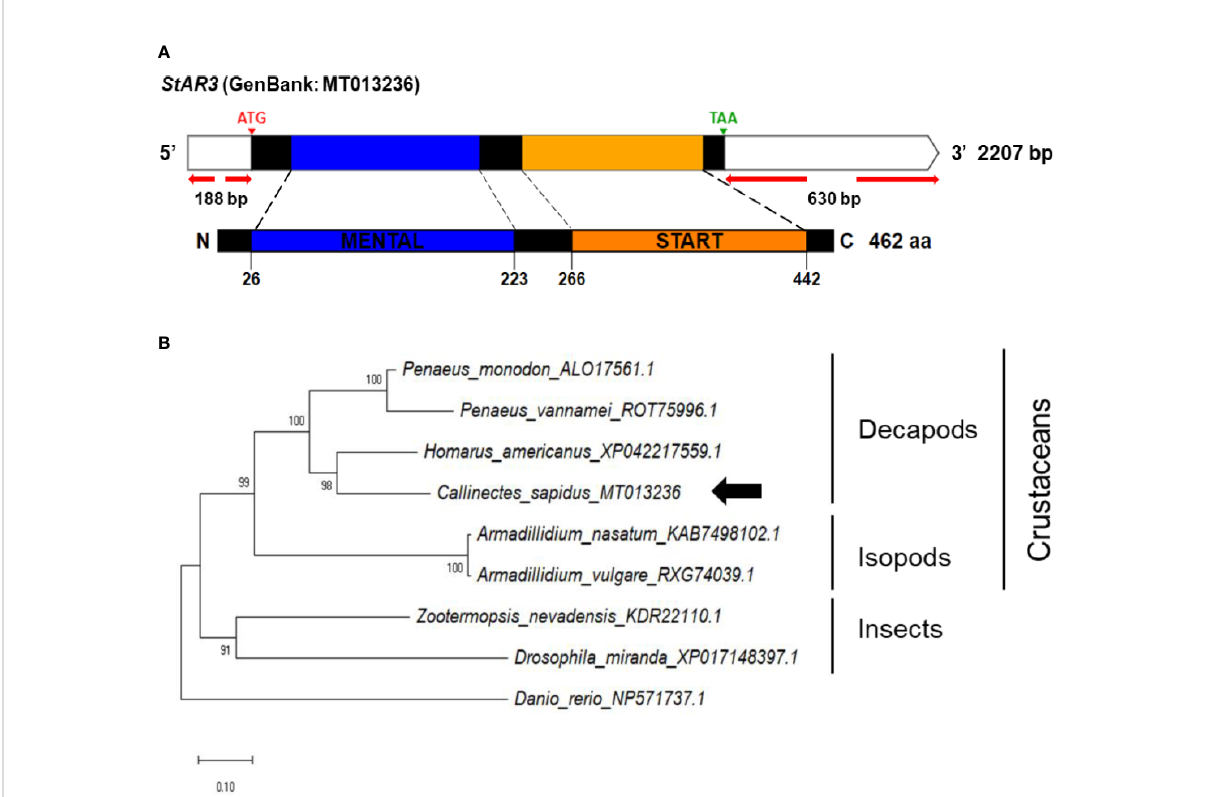
FIGURE 3 (A) Schematic representation of C. sapidus StAR3. The conserved domains of StAR3 protein are shown in different colors (MENTAL: cholesterol- capturing domain; START: StAR-related transfer domain). (B) Phylogenetic tree of StAR3 was constructed using neighbor-joining (NJ) approach in MEGAX. The amino acid sequences of StAR3 of crustaceans, insects and zebra fi sh were retrieved from NCBI database. Bootstrap consisted of 1000